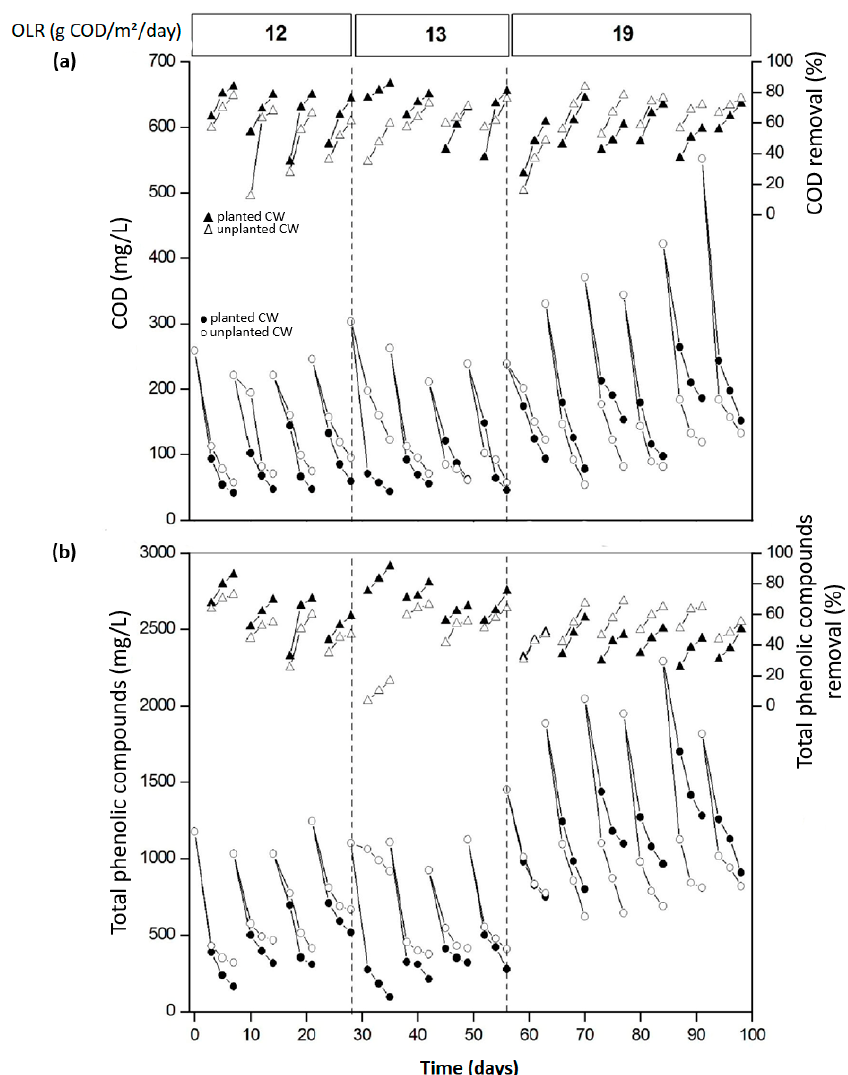
Figure 3. Variations of ( a ) effluent chemical oxygen demand (COD) and ( b ) effluent total phenolic compounds concentration and respective removal rates in the planted and unplanted CW treating P. radiata